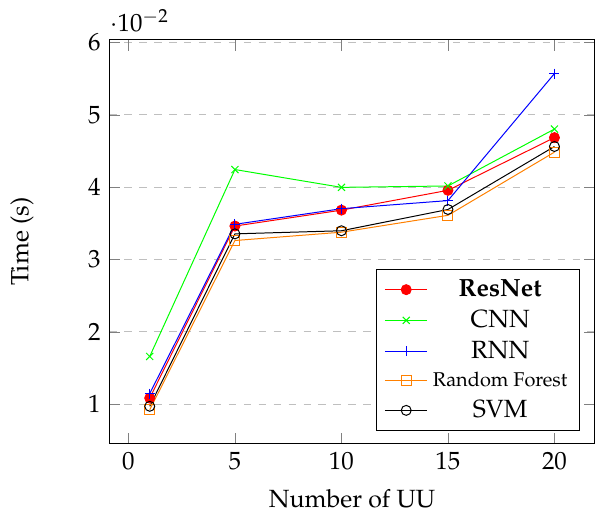
Figure 12. Time response of the entire system of the proposed ResNet model with other machine learning and deep learning approaches taking into consideration the variation of